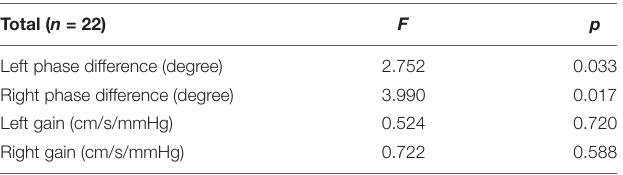
TABLE 2 | Summary of repeated measurements for dynamic cerebral autoregulation (dCA) parameters across different days during remote ischemic conditioning (RIC).